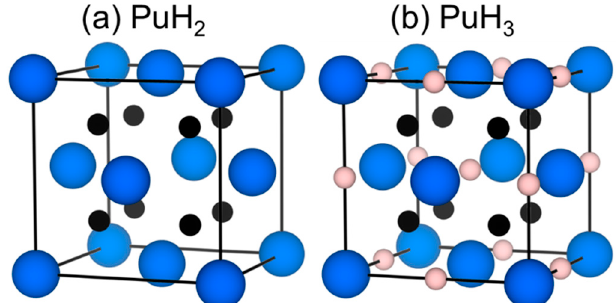
Figure 1. Crystal structures of cubic ( a ) PuH 2 and ( b ) PuH 3 . Pu in blue and H occupying tetrahedral sites (H T ) in black and octahedral sites (H O ) in pink.